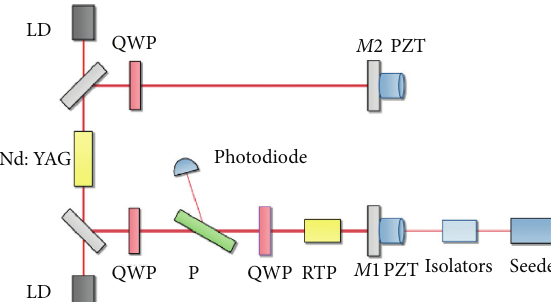
Figure 20: Structure of a SLM laser based on torsion mode cavity and resonance detection technology [74].